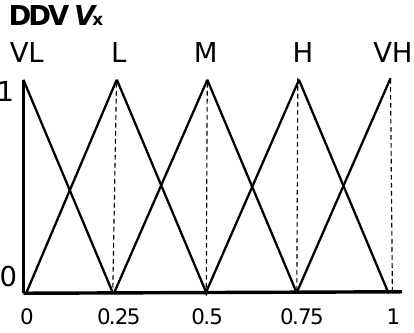
Figure 2. Domain of definition of the variable V x , i.e., V 1, V 2, V